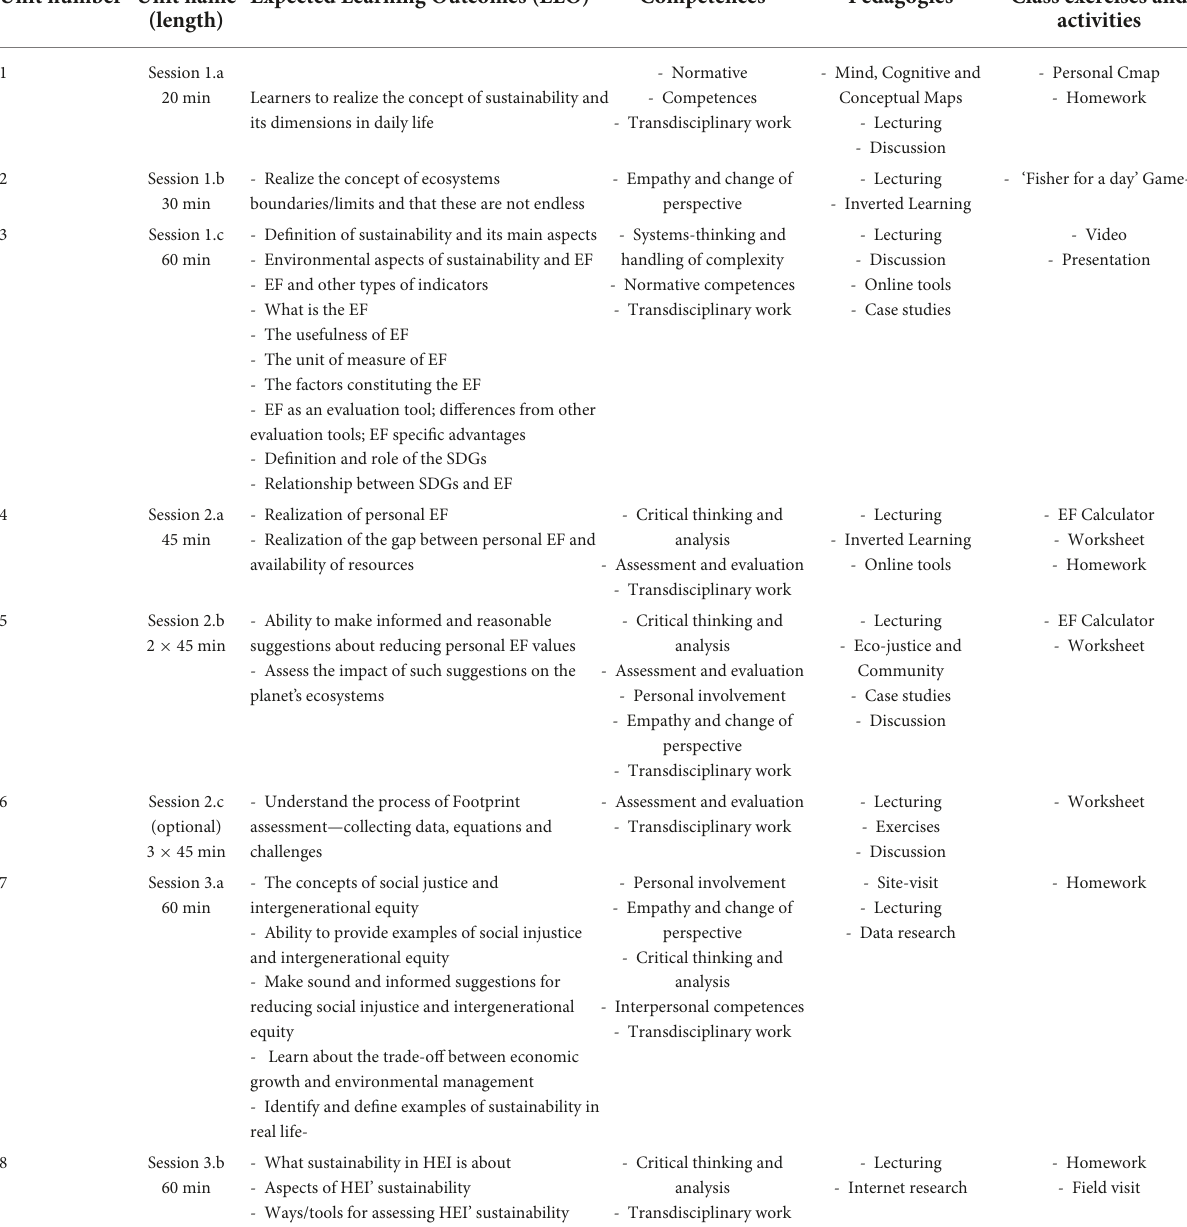
TABLE 3 EUSTEPs initial, pre-testing Module’s structure. Unit number Unit name